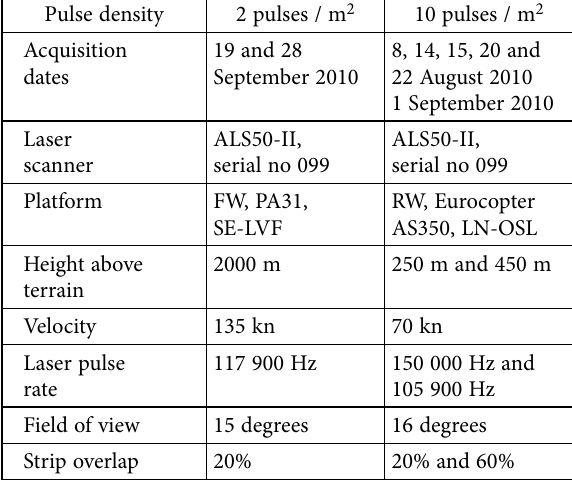
Table 1. Laser scanning acquisition